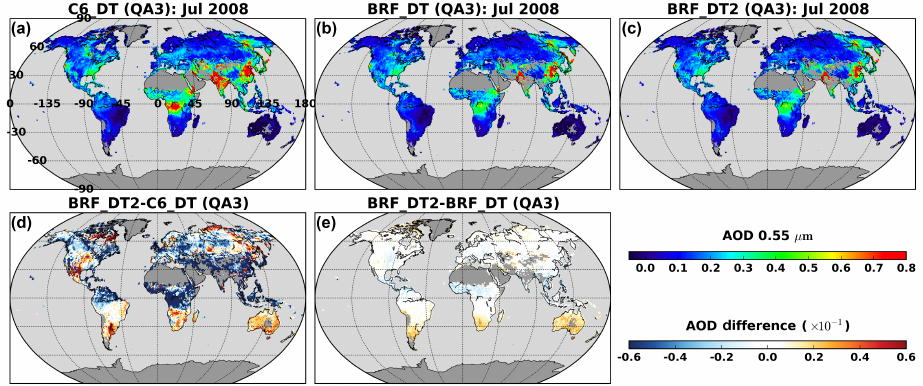
Figure 8. July 2008 maps (1 ◦ × 1 ◦ ) of mean AOD filtered with the best-quality QA = 3 (labeled as QA3) over global land. Other symbols are similar to Fig. 7.